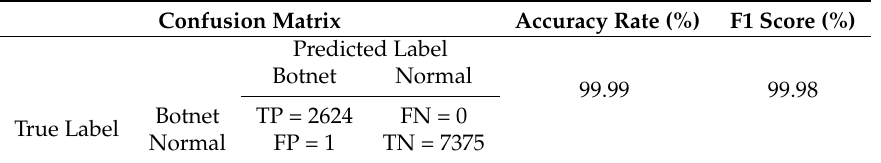
Table 3. Analysis of confusion matrix of victim model in classification of botnet and normal traffic data.